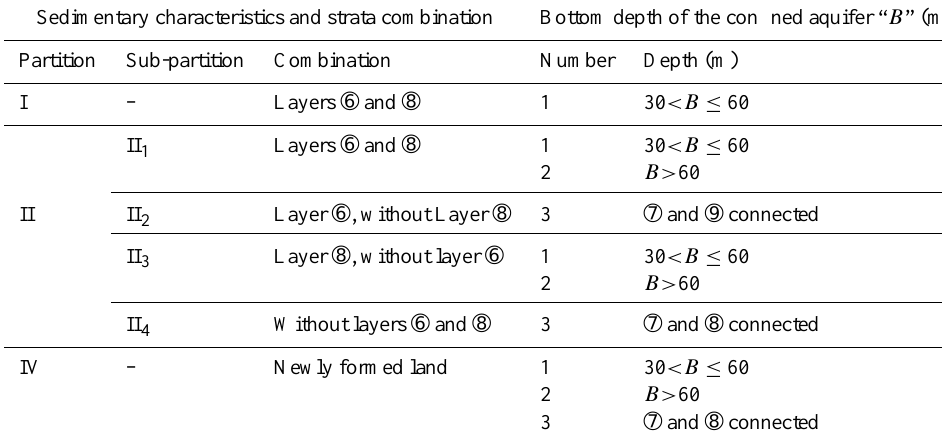
Table 3. Prevention partition for land subsidence induced by engineering dewatering.